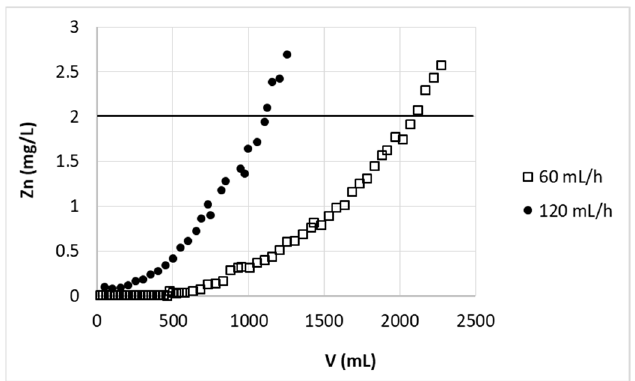
Figure 3. Effect of flow rate on zinc(II) ions removal on hybrid pectin-based biosorbent. Mass of sorbent (dry form, fine grain): 2 g (5.7 cm); flow rate: 60 mL/h or 120 mL/h; initial concentration of Zn: 30 mg/L; pH = 6.